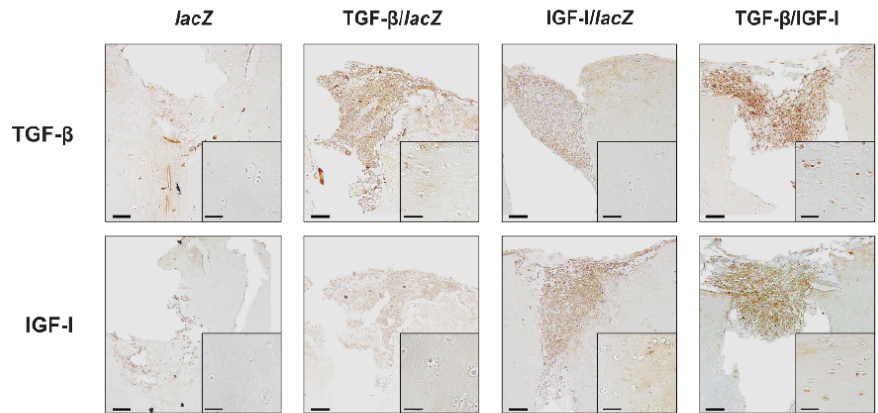
Figure 2. Detection of transgene (TGF- β , IGF-I) overexpression in human OCDs following implantation of rAAV-transduced hMSC aggregates. Aggregates were cotransduced with rAAV TGF- β / IGF-I, TGF- β / lac Z, IGF-I / lac Z or transduced with rAAV lacZ and implanted in human OCDs as described in Figure 1 and in the Materials and Methods. Samples were processed after 21 days to detect the expression of TGF- β and of IGF-I by immunohistochemistry (magnification × 10; insets showing the surrounding cartilage in the region immediately adjacent to the implanted pellets at magnification × 20; representative data). Scale bars: 100 µ m, insets: 50 µ m.